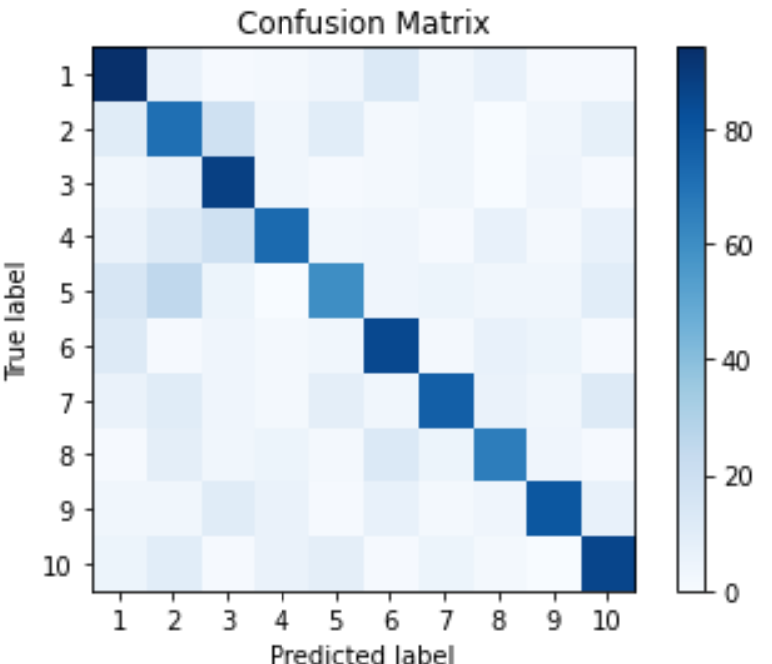
Figure 3. Graphical representation of the confusion matrix.